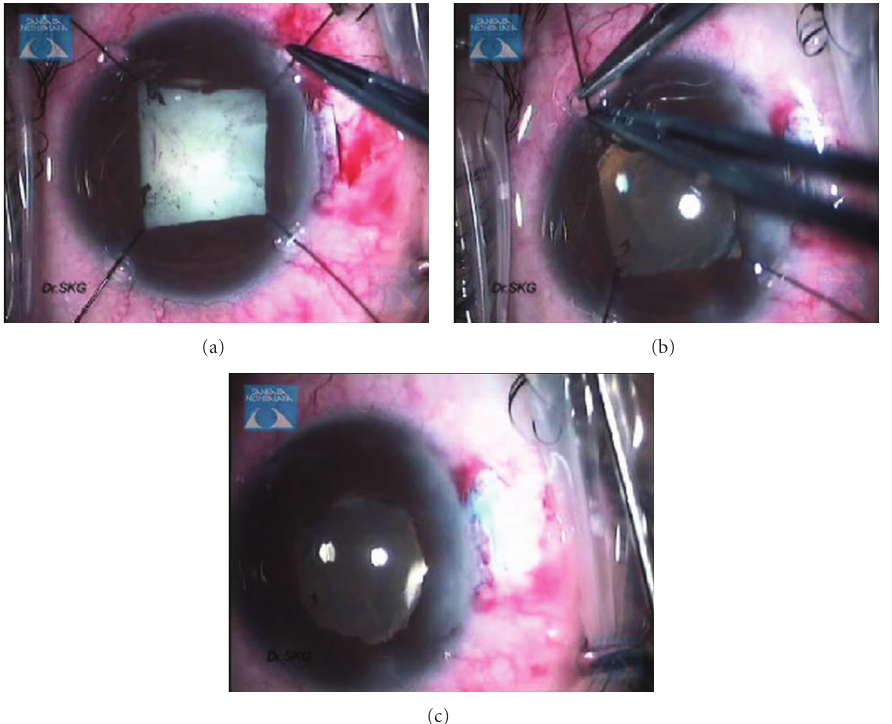
Figure 7: Postoperatively removal of self-retaining iris